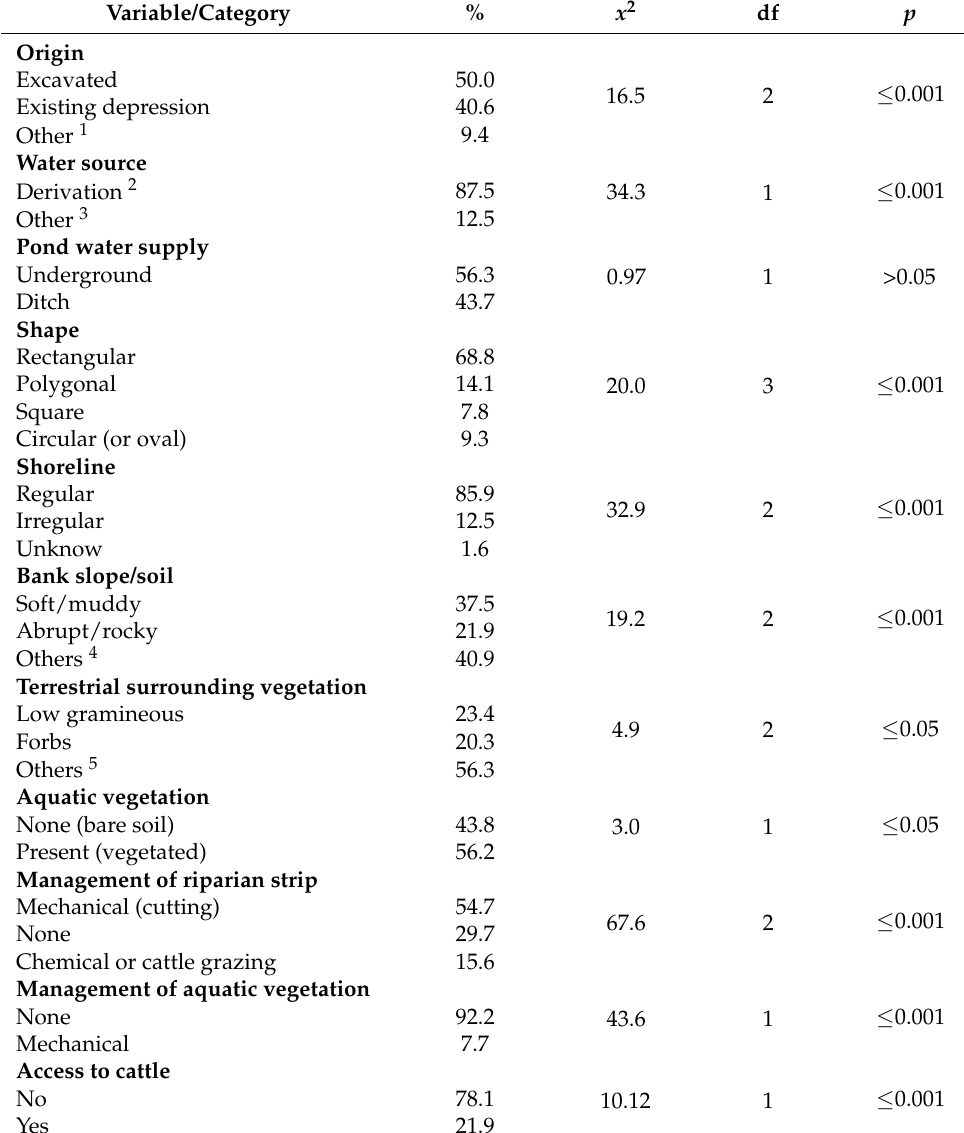
Table 2. Characteristics of the 61 farm ponds studied in the Boyer River watershed, St. Lawrence Valley lowlands, Southern Quebec (Canada). Sample size differs for the following variables: pond origin ( n = 54) and access to cattle ( n =